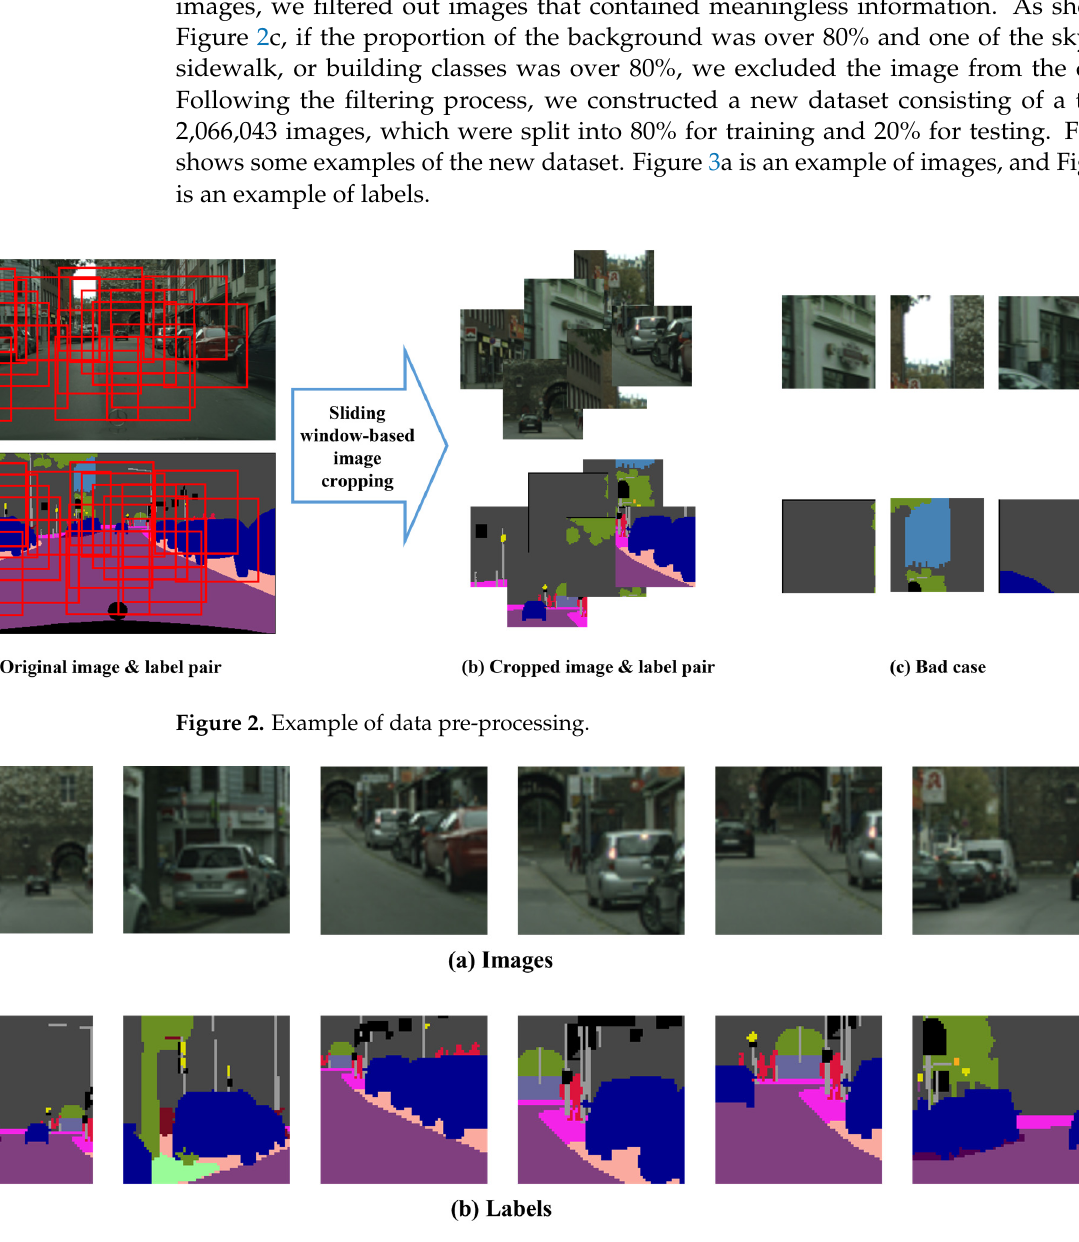
Figure 3. Sample of constructed new dataset.